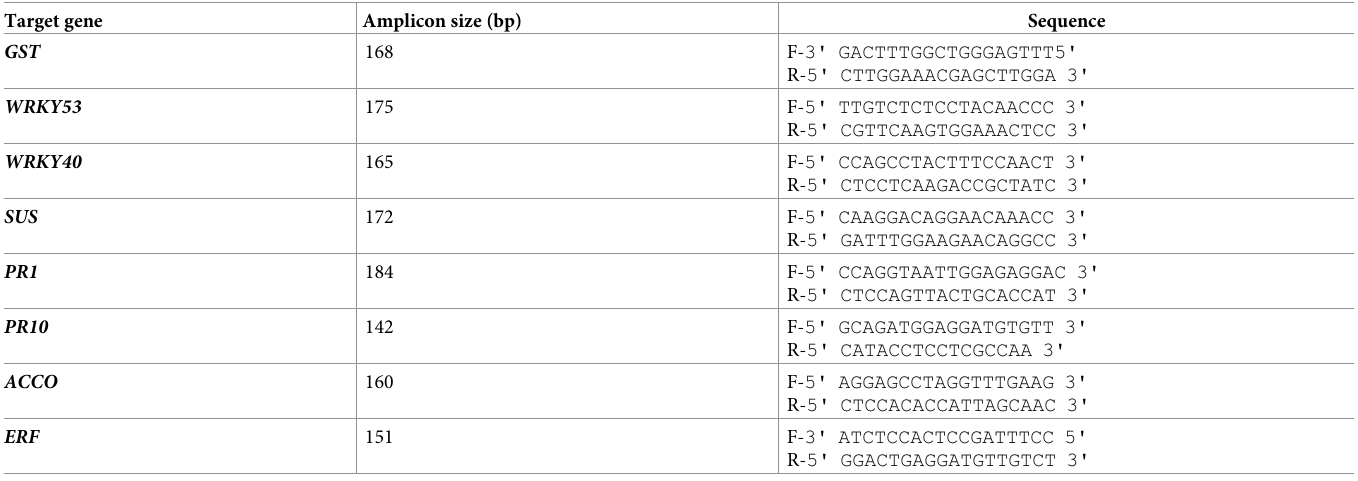
Table 1. The primers were designed in this study for q-RT PCR. Target